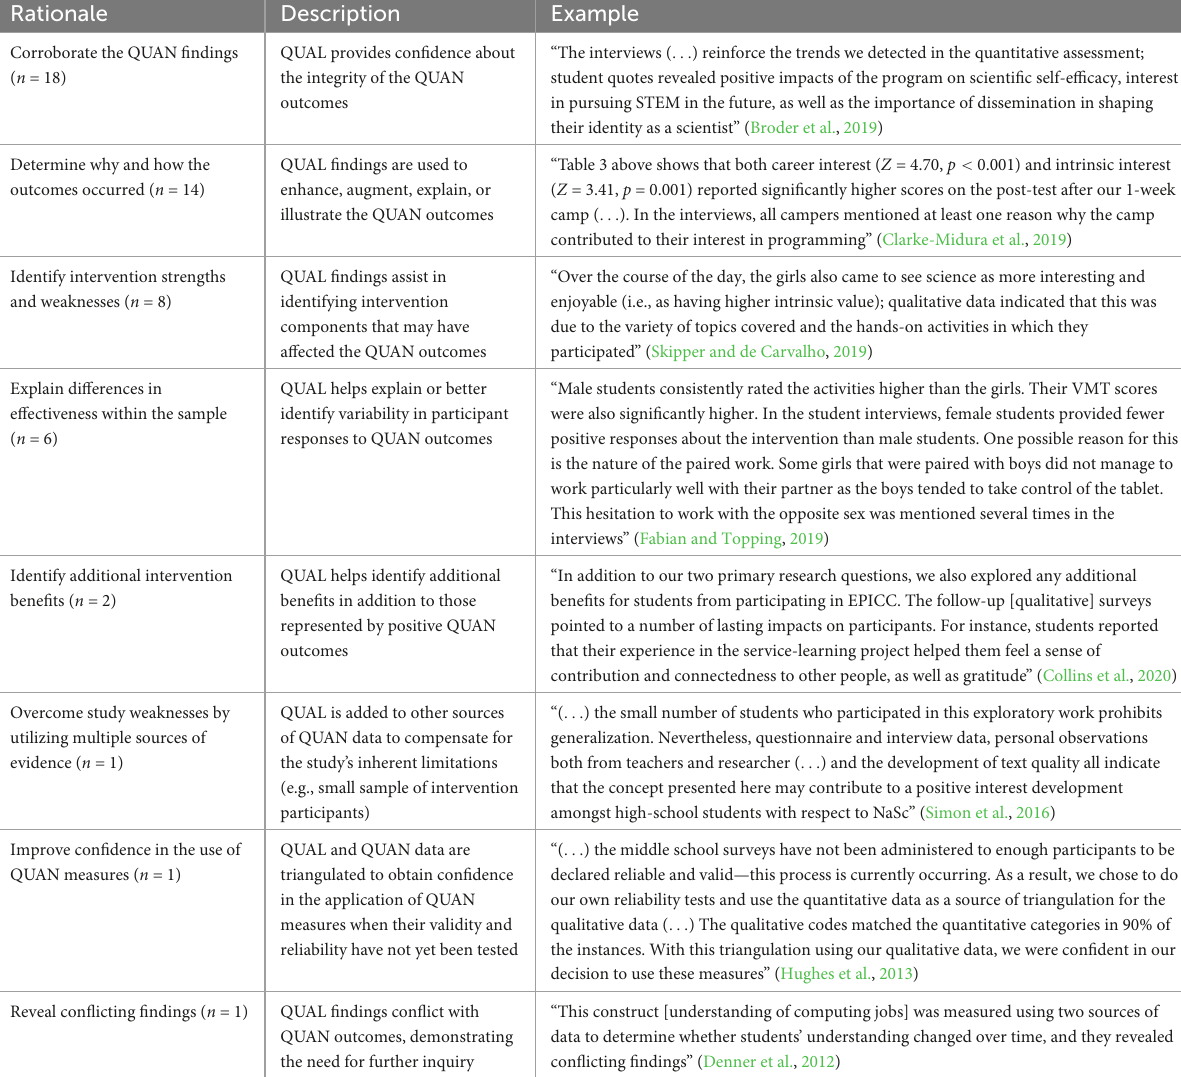
TABLE 2 Rationales for using qualitative research to generating additional evidence of